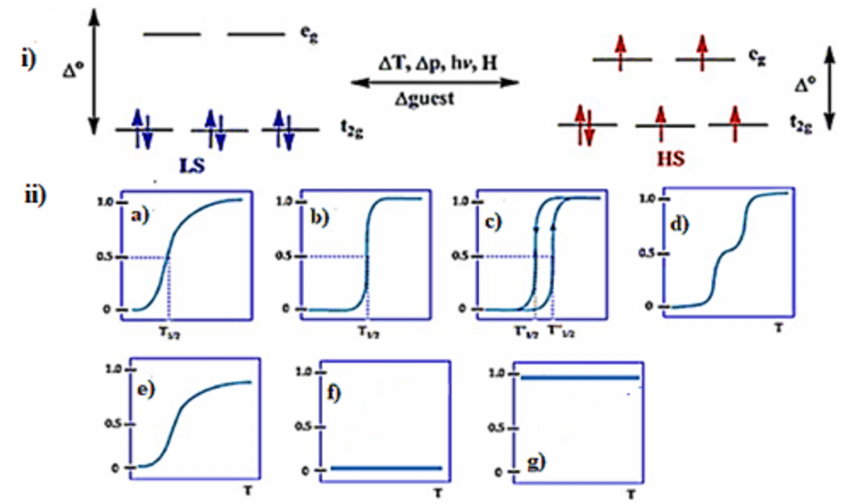
Figure 2. ( i ) The d orbital splitting diagram for an octahedral iron(II) ion. ( ii ) Various types of SCO behavior: ( a ) gradual ( b ) abrupt ( c ) with hysteresis ( d ) two-step transition (plateau) ( e ) incomplete ( f ) low spin and ( g ) high spin. Reproduced with modification with permission from [32]; Published by Royal Society of Chemistry,